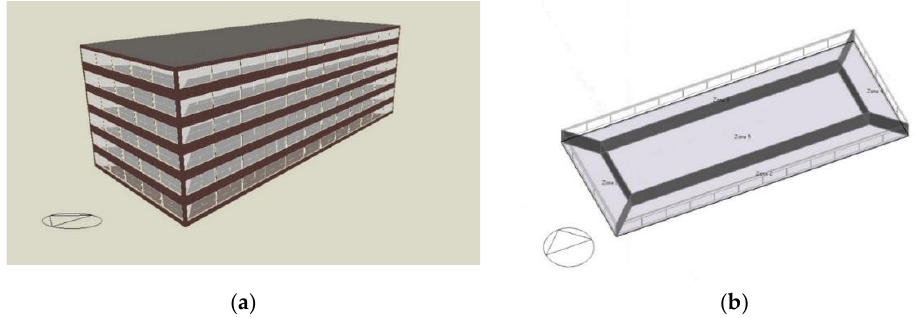
Figure A2. ( a ) Building shape and ( b ) floor layout of Case 1 (an office located in Shanghai, China).